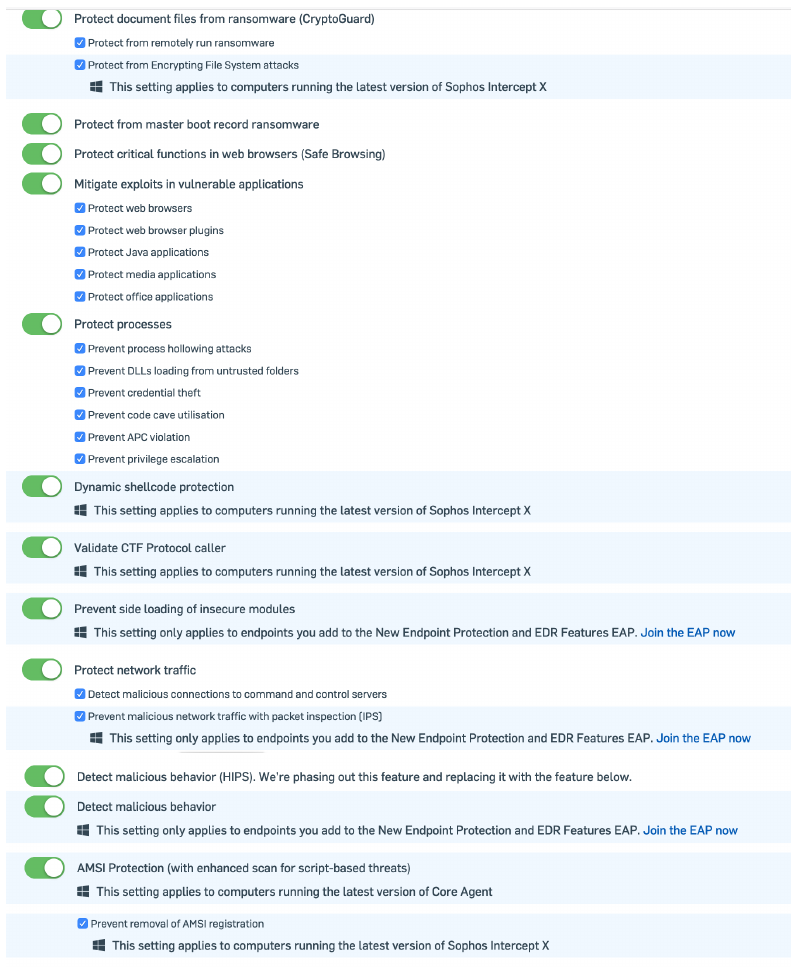
Figure 18. The settings for